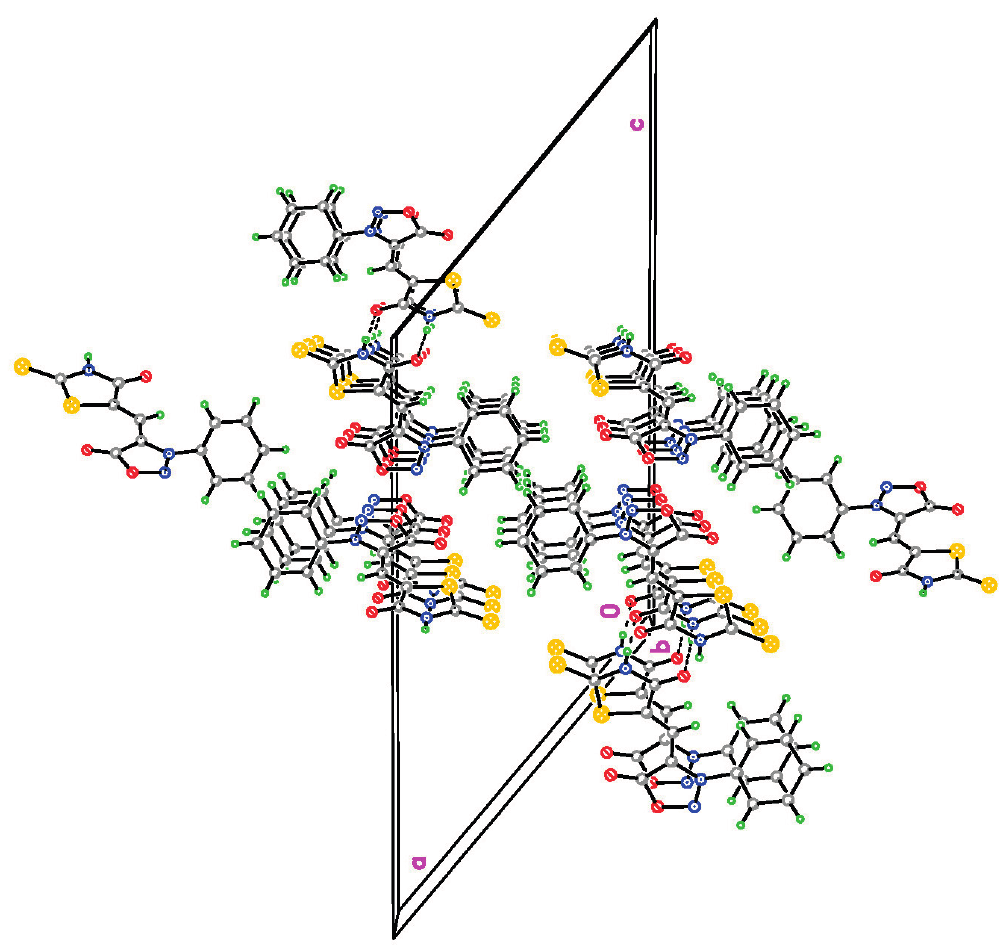
Figure 3. View along the b axis of packing diagram of compound 5a